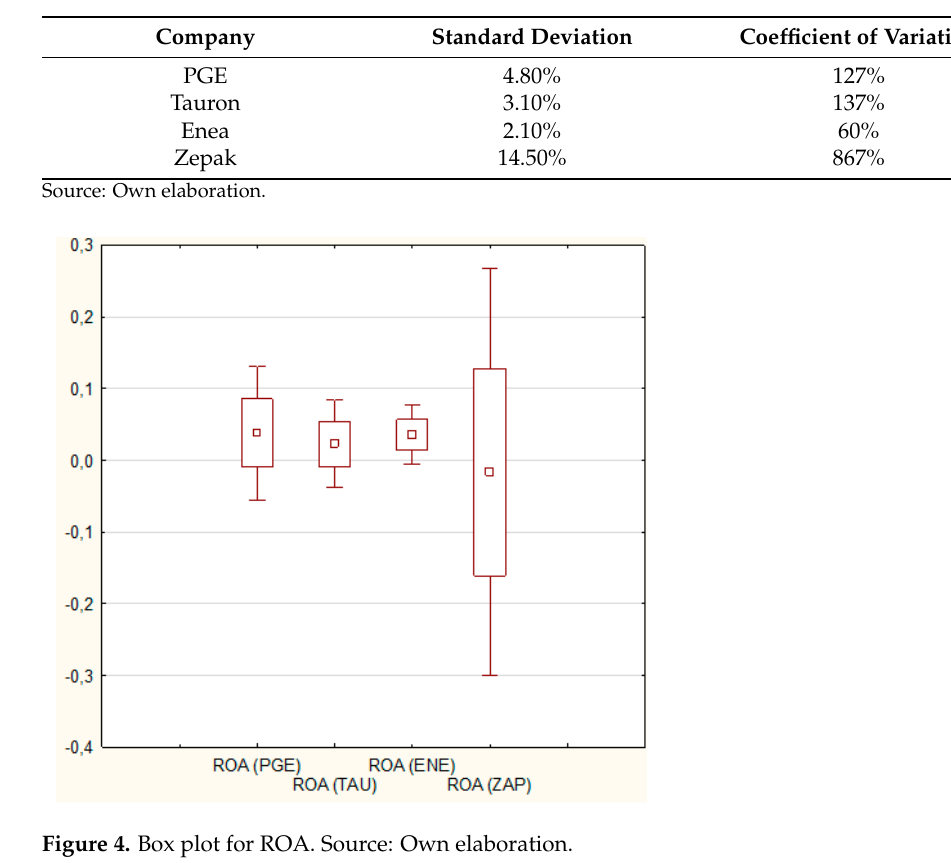
Figure 3. Dendrogram grouping the surveyed companies in terms of ROA. Source: Own elaboration. Table 2. Coefficients of variation and standard deviations for ROA of the surveyed companies.